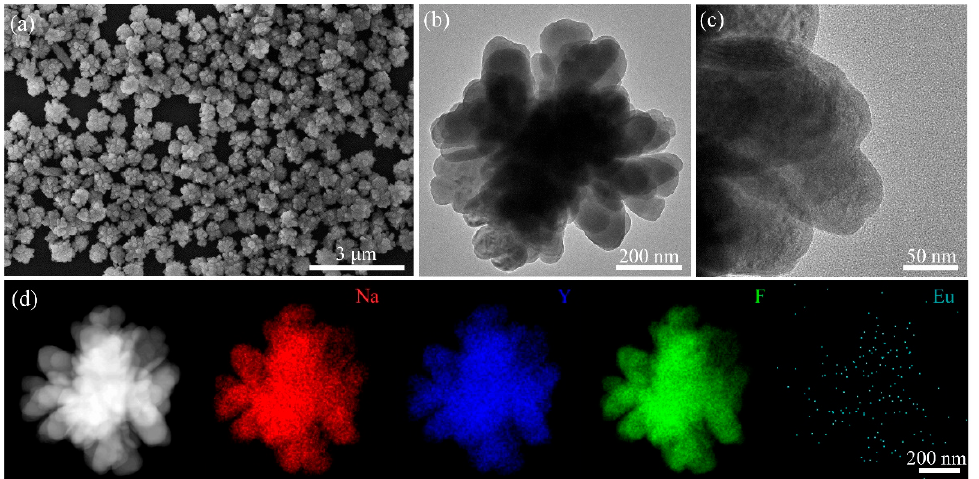
Figure 3. ( a ) SEM image, ( b ) TEM image, ( c ) enlarged high-resolution TEM image, ( d ) HAADF-STEM image and EDX elemental mapping of the NaYF 4 :Eu 3+ flower-shaped nanocrystals. The luminescence spectrum of doped Eu 3+ is used to monitor the crystal transfor- mation of the matrix materials [28,29]. A low power (0.2 mW) 532 nm laser is used as the excitation source to obtain the luminescence spectrum, and a high power (23 mW) 976 nm laser is used as the irradiation light to drive the crystal transformation. The in situ lumi- nescence spectra of a single nanoflower before and after 976 nm laser irradiation are shown in Figure 4a. Wide bands of luminescence centered at 590 nm, 615 nm and 700 nm with weak intensity are observed, which indicates the poor crystallinity of the initial NaYF 4 . After laser irradiation, there is a sharp band at 610 nm with strong luminescence intensity, indicating that the nanocrystal has better crystallinity. From the inset in Figure 4a, it can be seen that the single flower-like NaYF 4 nanocrystal is transformed in situ into a spherical particle. The distribution of Y, O and Al elements in the product shows that the NaYF 4 :Eu 3+ particle transformed to Y 2 O 3 :Eu 3+ after laser irradiation (Figure 4b). More details on the product can be found in previous work [8]. Because of the short relaxation time and the high temperature of the plasmonic photothermal effects, it is difficult to detect and measure the heat production by conventional methods. On the other hand, thermal effects play an important role in the plasmon driven crystal transformation, and hot electrons play an auxiliary and synergistic role. Therefore, the irradiation time of the plasmon-driven rare-earth-doped luminescent nanocrystal transformation is used to estimate the plasmonic photothermal effects. The rate of the above crystal transformation can be easily